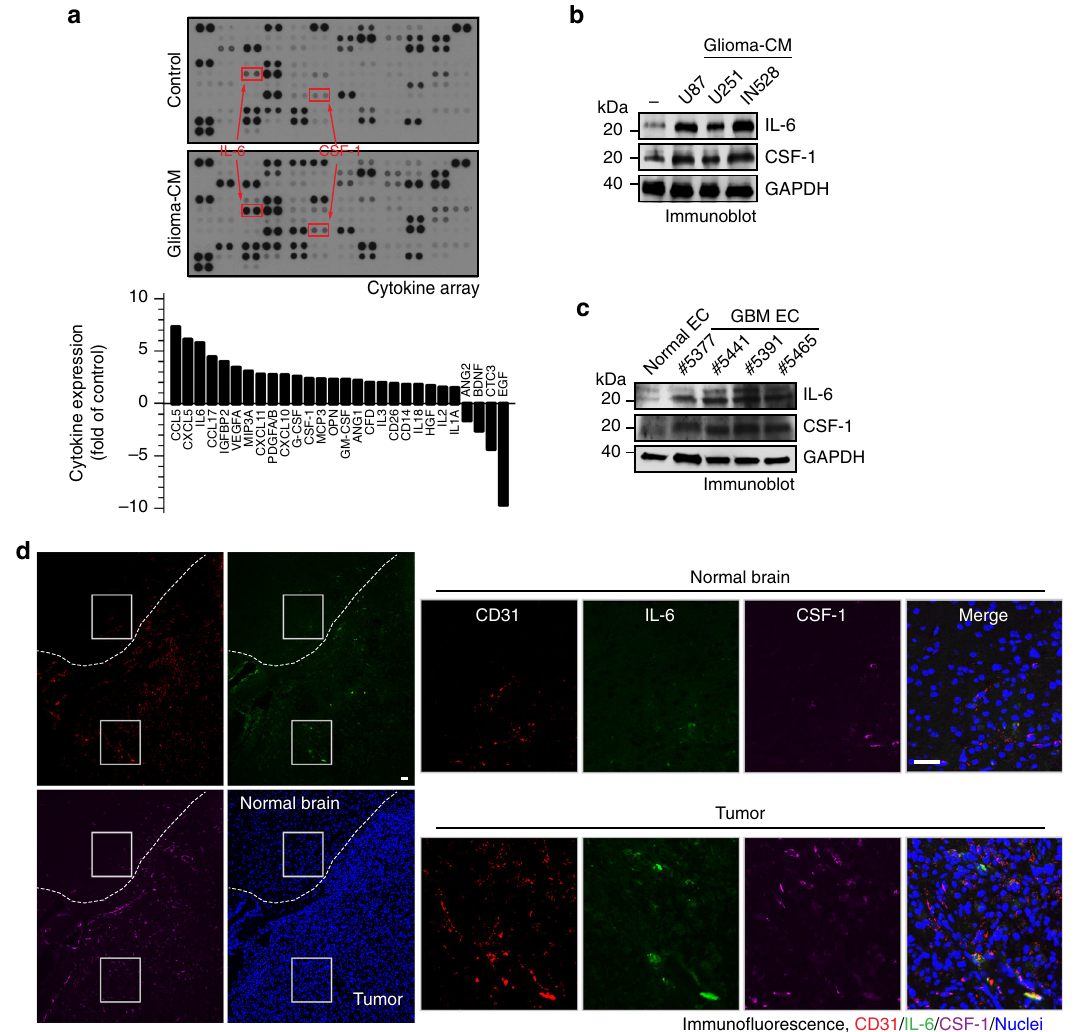
Fig. 3 GBM ECs express IL-6. a Human brain ECs were treated with glioma-CM for 24 h, and cell lysates were subjected to multiplex cytokine array analysis. Left, a representative blot. Right, quanti fi ed dot intensity of most signi fi cantly changed cytokines. b Human microvascular brain ECs were treated with glioma-CM that were harvested from different human glioma cells. Cell lysates were immunoblotted. c Human microvascular brain ECs and tumor- associated ECs isolated from different GBM patients were subjected to immunoblot analysis. d Mouse GBM was induced by orthotopic injection of GL26 glioma cells into wild-type mouse. The brain sections that include normal brains and tumors were stained with anti-CD31, anti-IL-6, and anti-CSF-1 antibodies. Representative immuno fl uorescence images are shown. Right, enlarged area in normal and tumor tissues. Bar represents 50 μ m. Zoom-in factor: